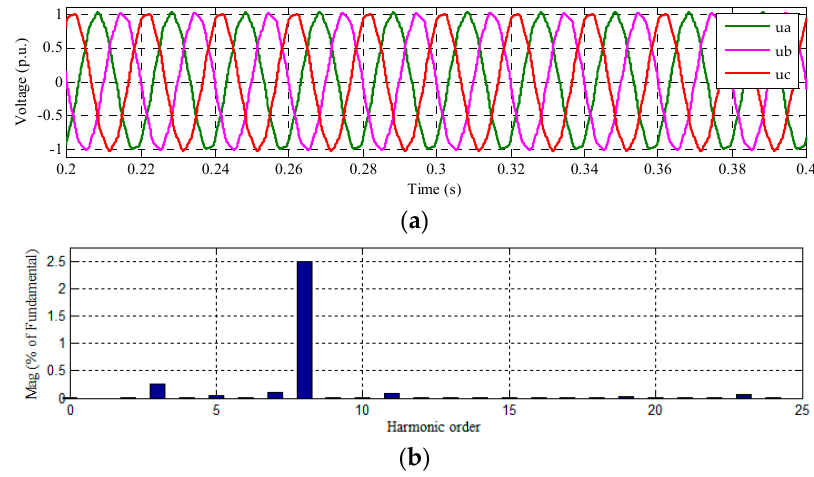
Figure 2. ( a ) 3-phase voltage waveform with the required distortion of 8th harmonic testing; ( b ) Voltage spectrum for the standard testing waveform.